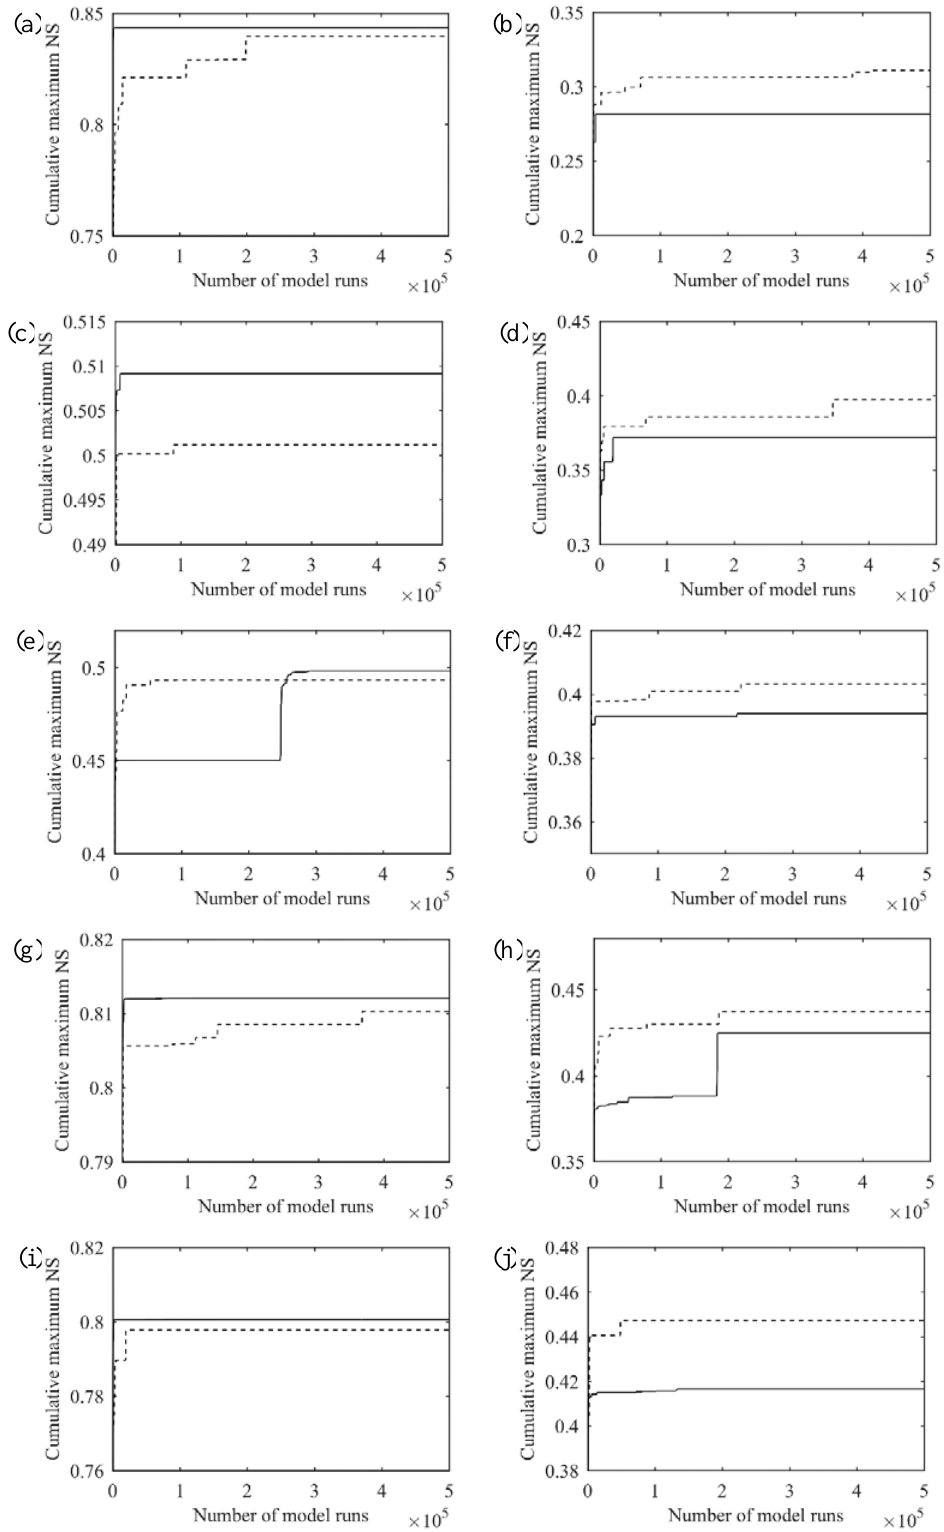
Figure 6. Convergence plot for the NS coefficient. The solid and dashed lines represent ISPSO-GLUE and GLUE, respectively. ( a ) 2003 calibration, ( b ) 2003 validation with all models, ( c ) 2003–2004 calibration, ( d ) 2003–2004 validation with all models, ( e ) 2003–2005 calibration, ( f ) 2003–2005 validation with all models, ( g ) 2003–2006 calibration, ( h ) 2003–2006 validation with all models, ( i ) 2003–2007 calibration, ( j ) 2003–2007 validation with all models.